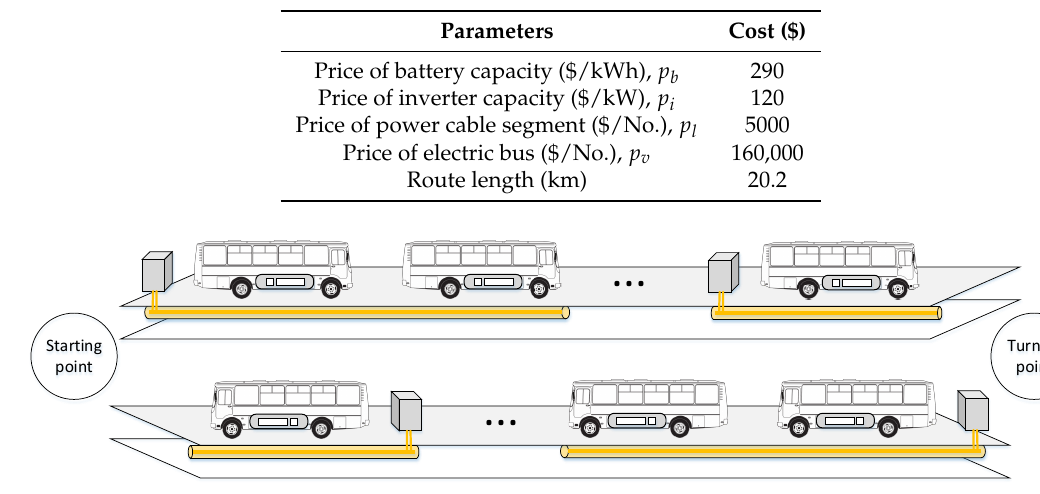
Figure 9. Layout of simulation